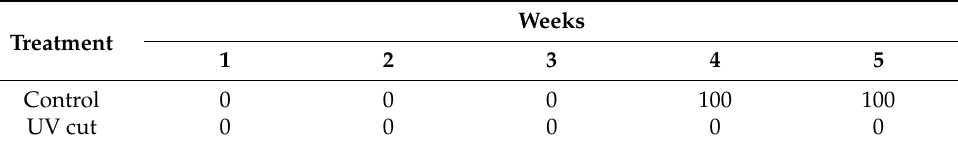
Figure 9. Effect of exposure to intermittent nocturnal lighting for 6 h with UV-B light on phytochemicals (perillaldehyde (PA), rosmarinic acid (RA)) concentrations (Experiment 3). Perilla plants were irradiated for 1 or 2 h every 1 or 2 h for 6 h, from 18:00 to 6:00. The UV-B radiation intensity at the canopy level was set to 0.05 or 0.1 W m − 2 . The integrated UV-B per night at 0.05 and 0.1 W m − 2 was 1.1 and 2.2 kJ m − 2 day − 1 , respectively. Leaves at the 4th node counted from the bottom of the main stem were harvested 1 week after treatment initiation; thereafter, leaves at the 5th, 6th, and 7th nodes were sampled from the same plants at 2, 3, and 4 weeks after treatment initiation. Vertical bars indicate SE ( n = 5). Different letters indicate significant difference among treatments at p < 0.05, and n.s. indicates no significant difference as per the Tukey-Kramer test. Table 4. Weekly flowering ratio of red perilla (Experiment 4, n = 5). The UV cut treatment was conducted by covering the UV-B lamp with a UV cut film to evaluate the effect of the visible light of UV-B lamps on flowering. Before covering the lamp with the film, the UV-B radiation intensity at the canopy level was set to 0.1 W m −2 . The weekly percentage flowering was determined by dividing the number of plants that formed flower buds by the number of plants tested. Perilla plants were irradiated for 6 h from 18:00 to 06:00.